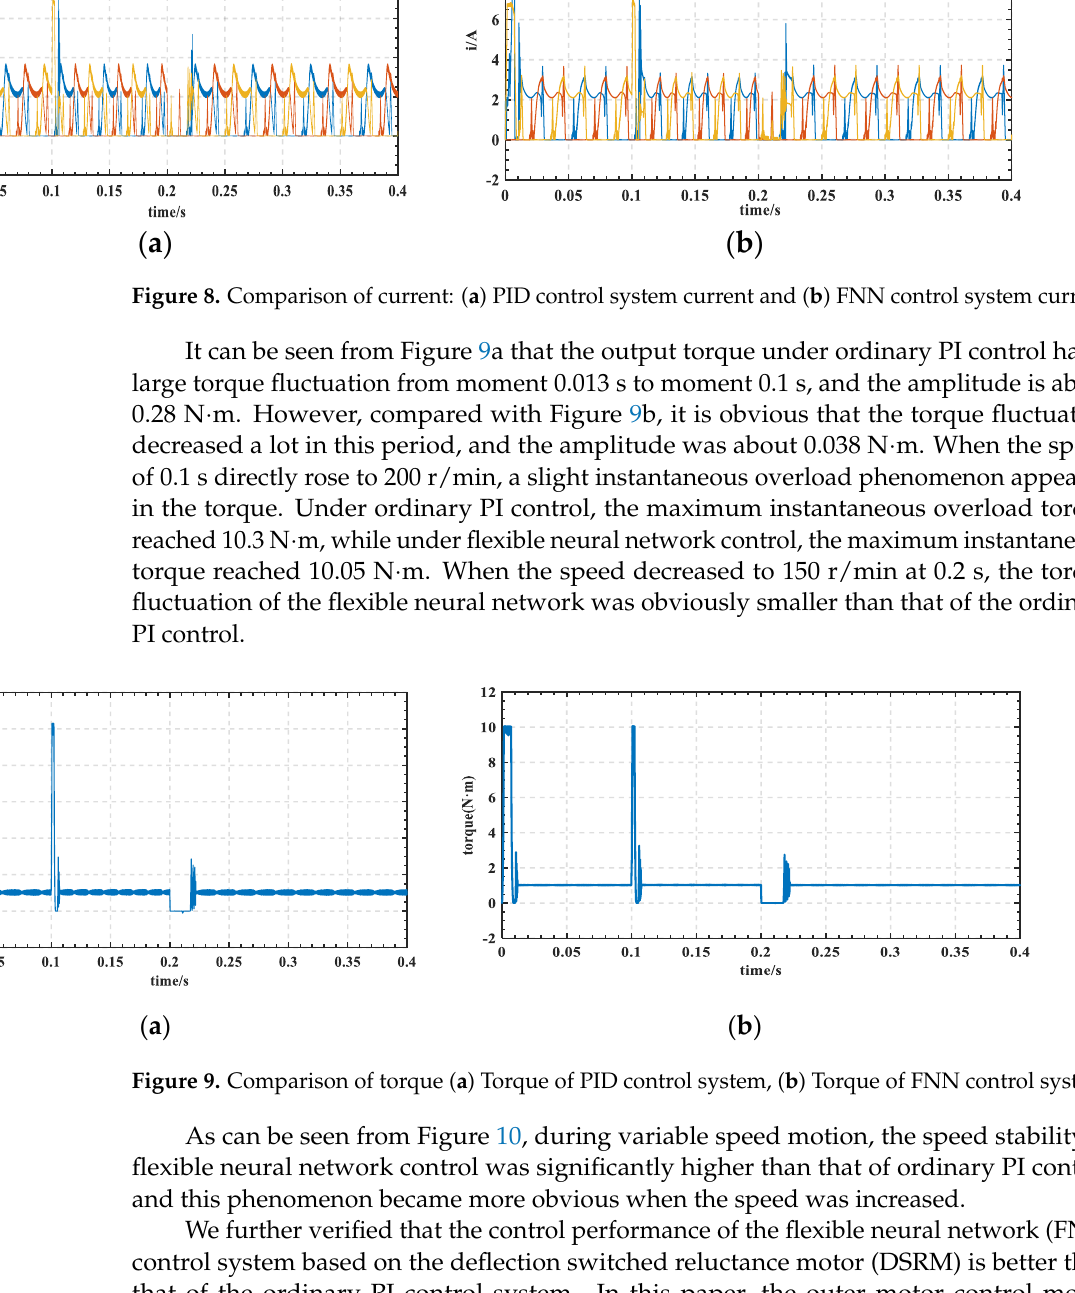
Figure 9. Comparison of torque ( a ) Torque of PID control system, ( b ) Torque of FNN control sys- tem.